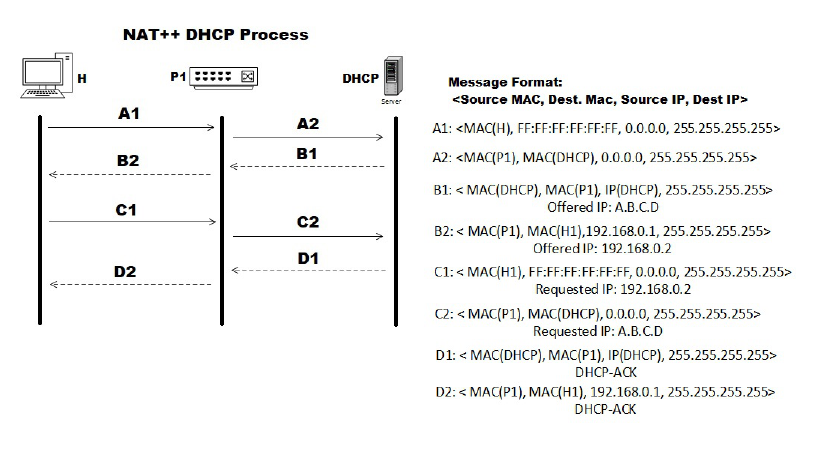
Figure 4. Sequence Diagram for the DHCP